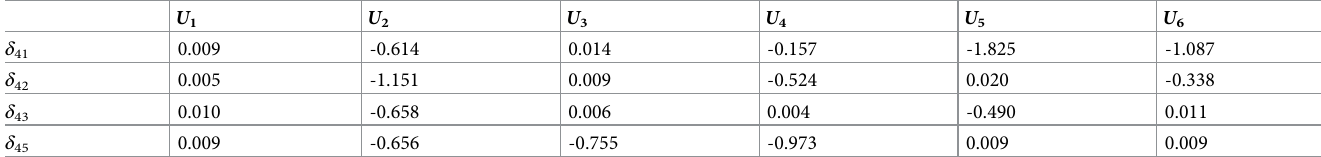
Table 22. The relative dominance of O 4 to